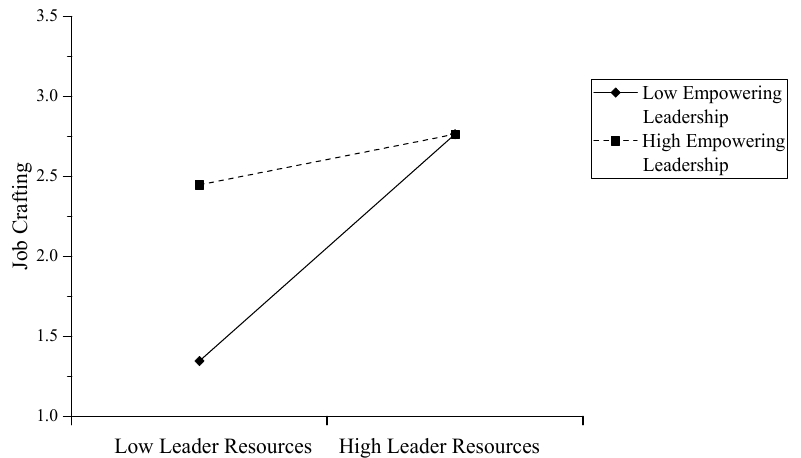
Figure 2. Interaction effect between empowering leadership and leaders’ job resources on team members’ job resources.